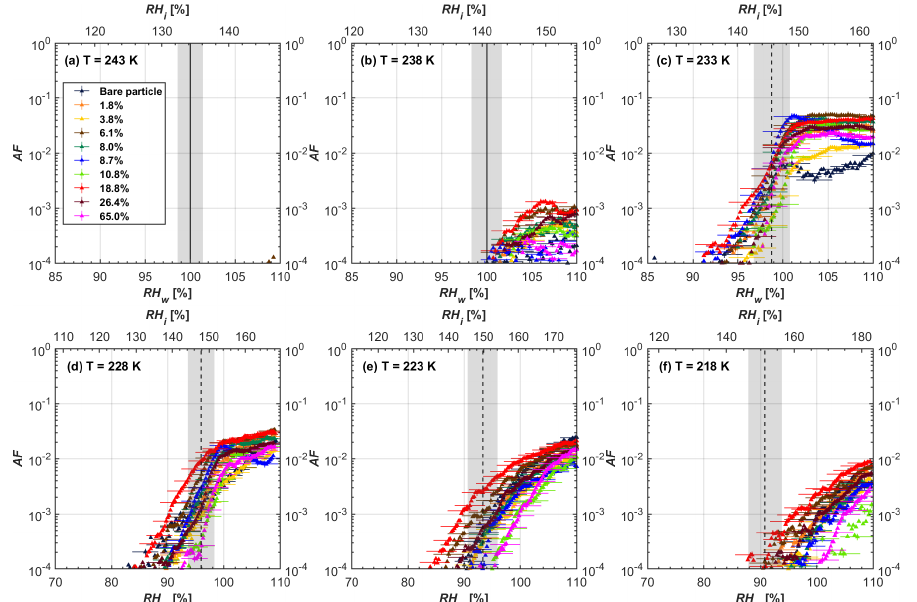
Figure B8. RH scans for bare and coated 400nm FW200 soot particles at nine different coating wt% corresponding to the 5µm OPC channel, presented as AF as a function of RH. Black solid lines represent water saturation conditions according to Murphy and Koop (2005). Black dashed lines denote the expected RH values for homogeneous freezing at T < HNT (Koop et al., 2000). The grey-shaded areas show the possible RH uncertainty calculated for water saturation and homogeneous freezing conditions. The percentage number represents the H 2 SO 4 coating mass ratio to the bare particle